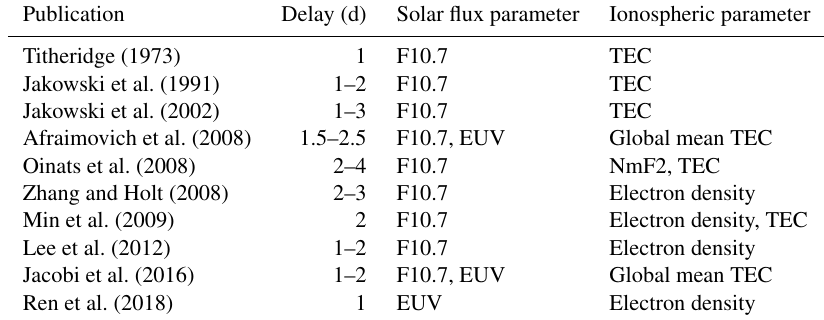
Table 1. This table presents results from studies that provide an approximate ionospheric delay to solar activity at a daily resolution.